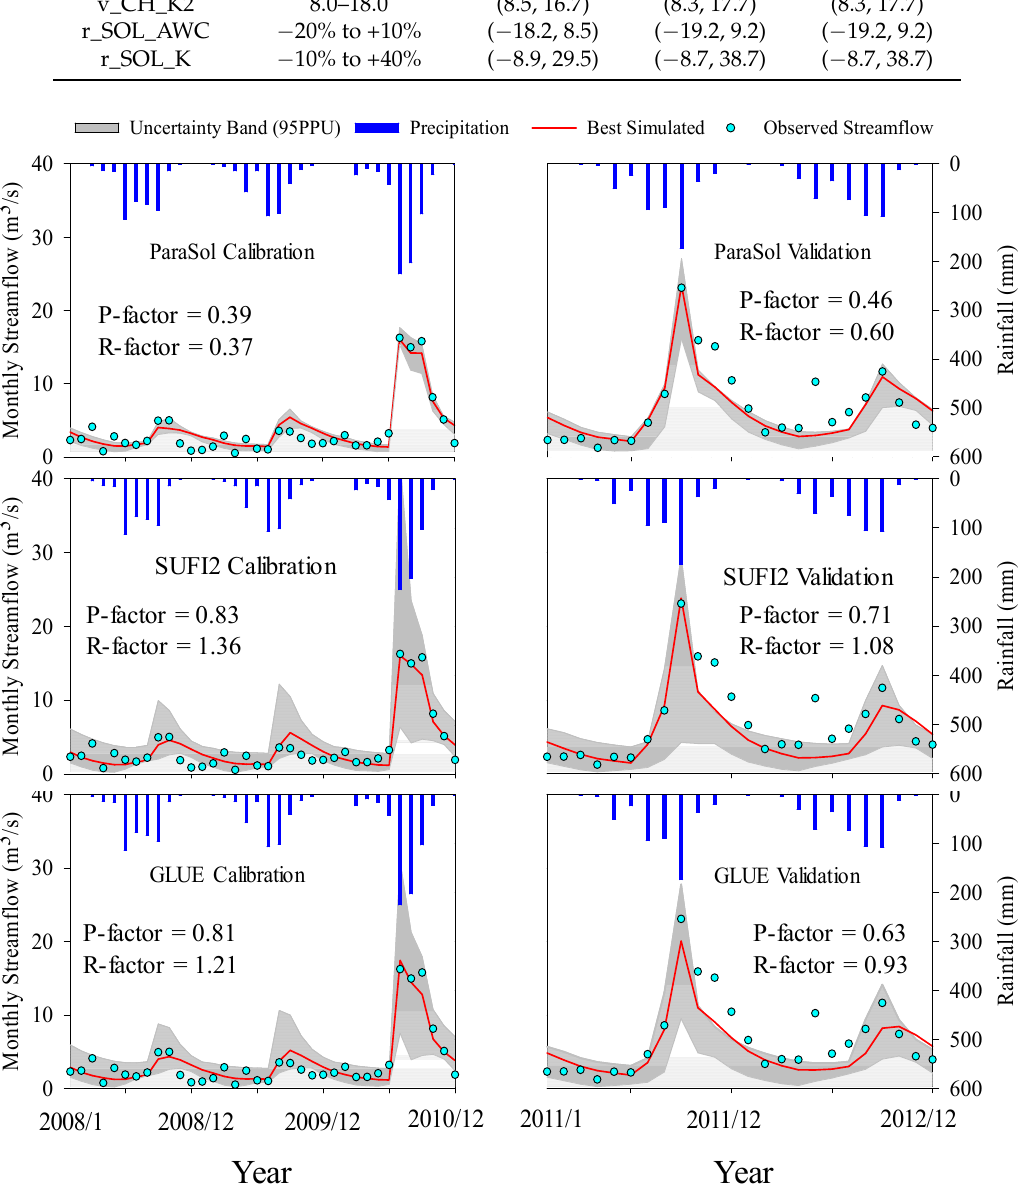
Figure 5. Comparison of best-simulated monthly streamflow with 95PPU against observed streamflow by ParaSol ( top ), SUFI2 ( medium ), and GLUE ( bottom ). P-factor indicates the percentage of observed data bracketed by 95% prediction uncertainty; R-factor reflects the average thickness of 95PPU band divided by the standard deviation of the measured data.